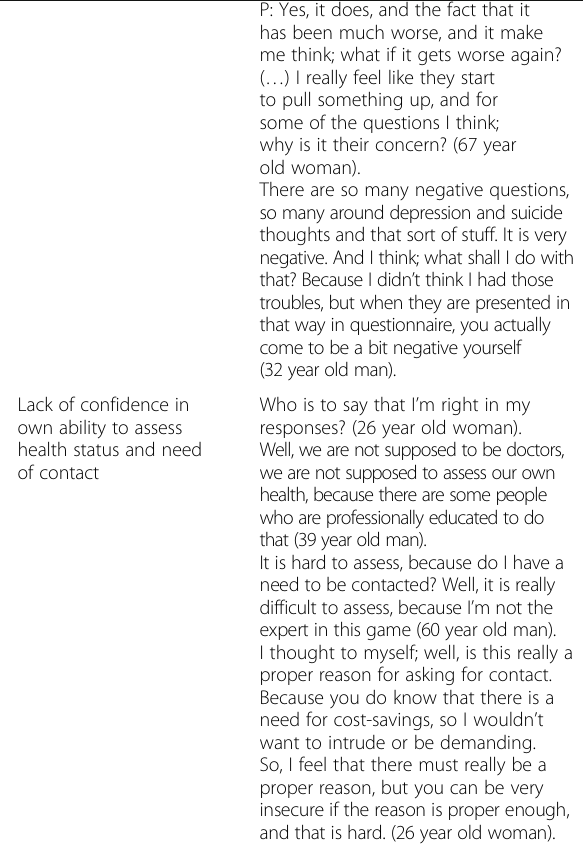
Table 2 Examples of participants ’ quotes